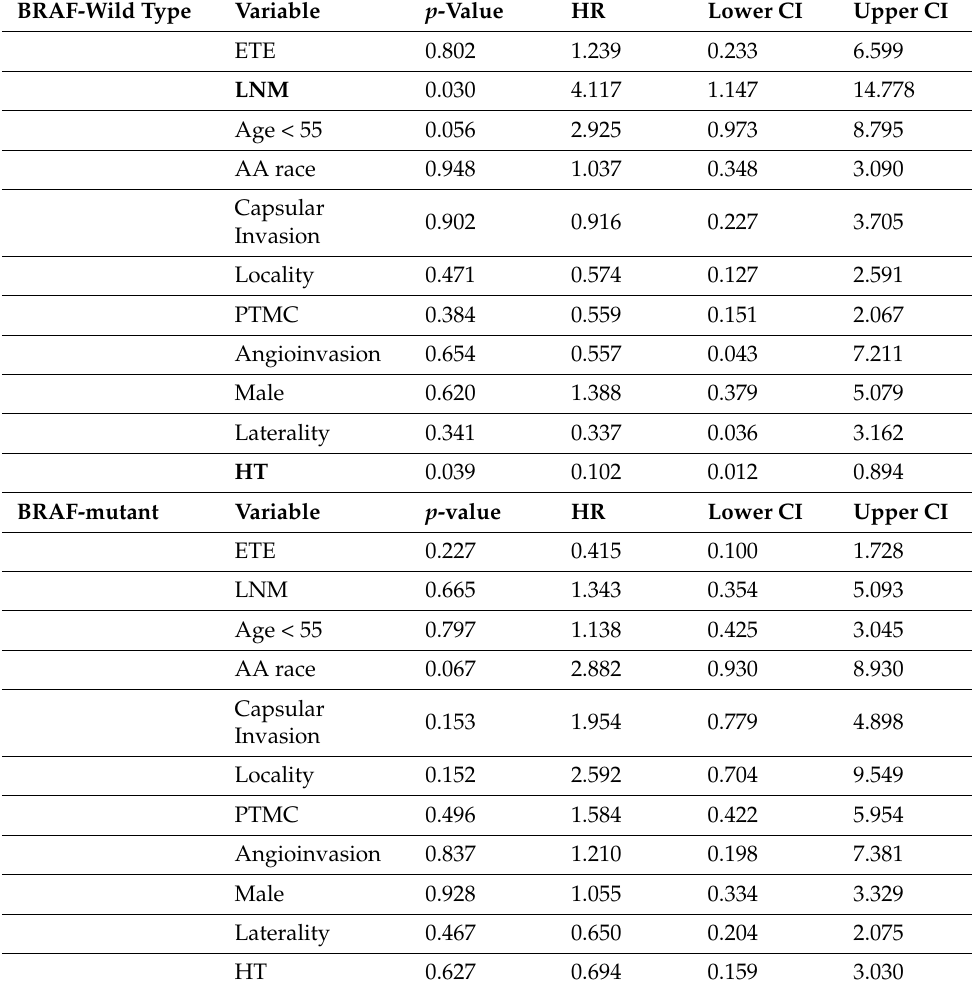
Table 5. Multivariate logistic regression analysis including only PTC patients to determine indepen- dent predictors of recurrence sub-grouped by BRAF mutation